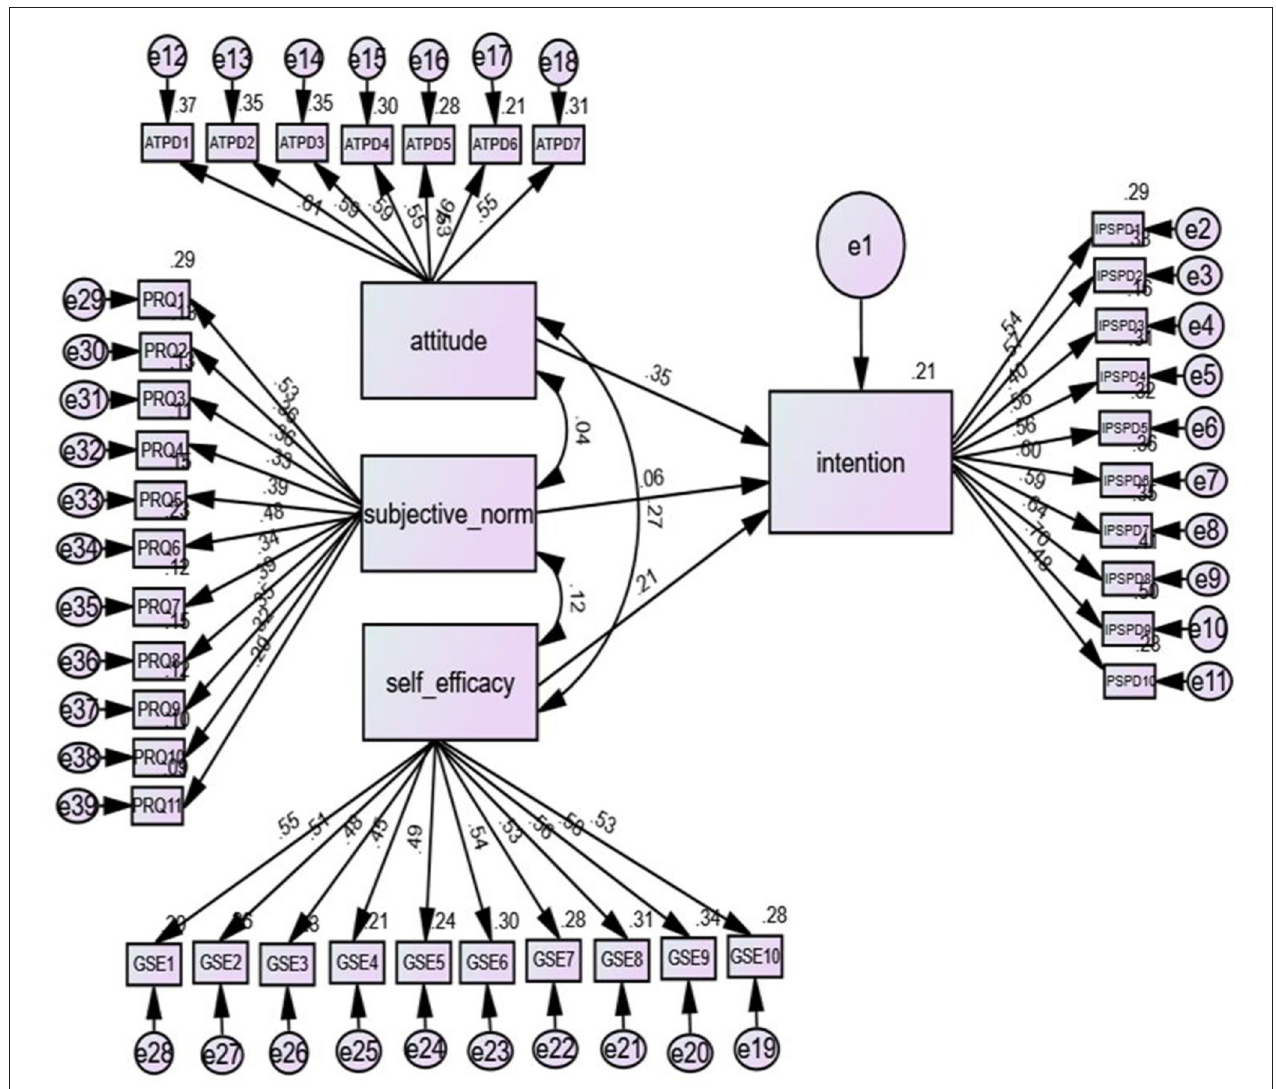
FIGURE 1 | Predictive Pathways From SEM.